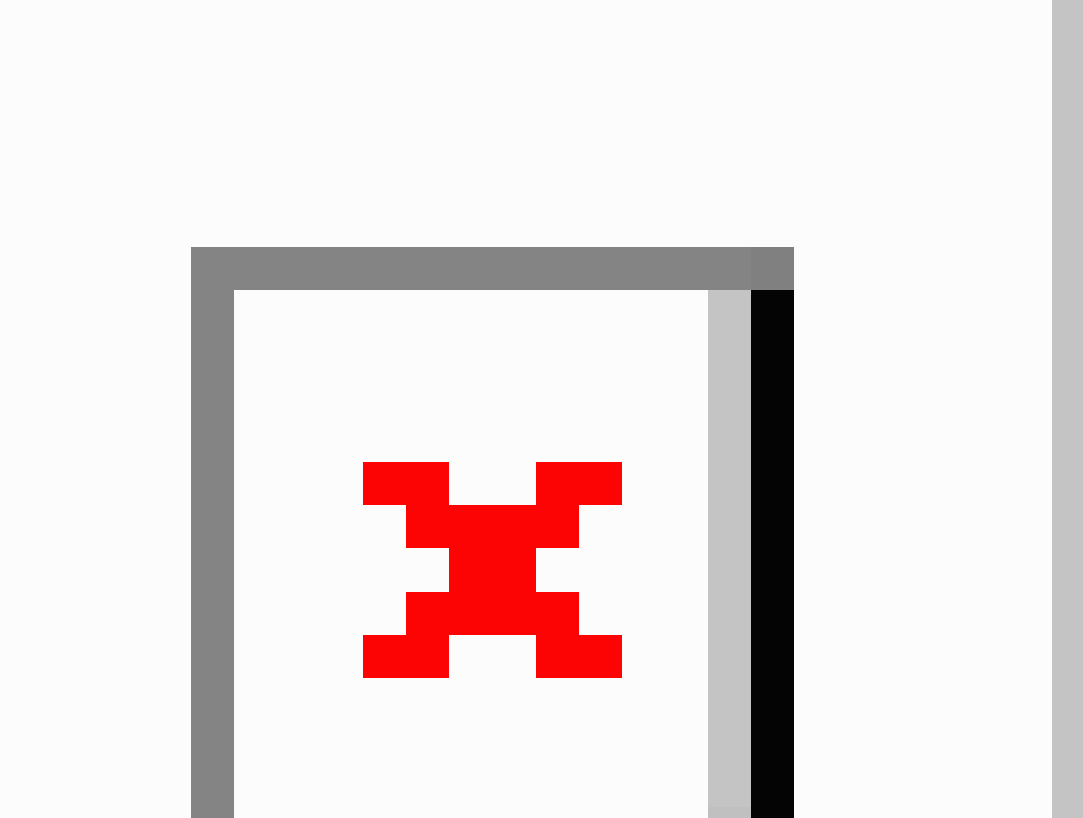
Figure 4. The univariate marginal effects of typical variables on the risk probability scores. The blue dots represent the CHD samples and the green dots represent the non-CHD samples in the training set. The y-axis shows the calculated risk probability scores (0=low risk, 1=high risk). The red curve shows the average risk probability at the given value/interval of the studied variables. CHD: coronary heart disease; SBP: systolic blood pressure; HTN: